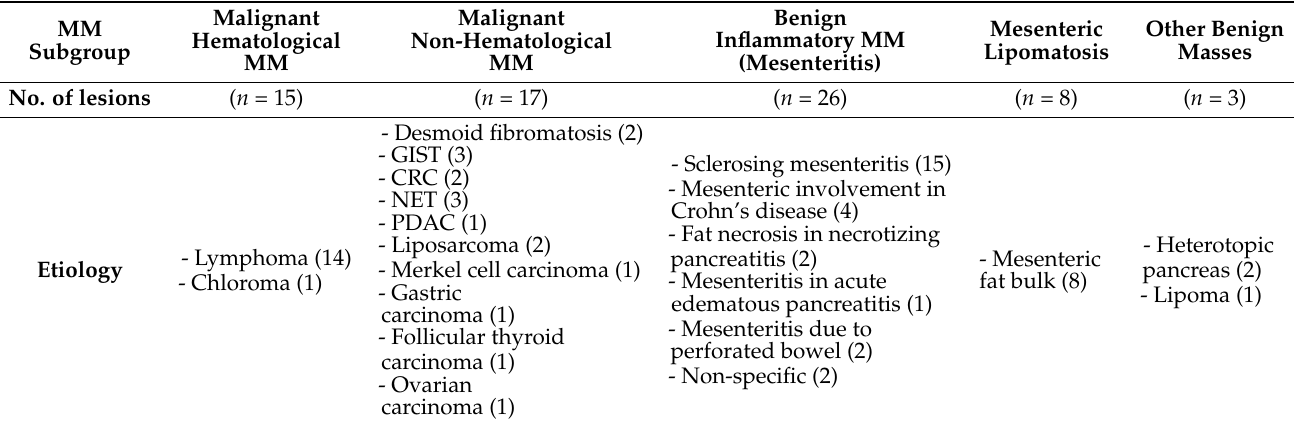
Table 1. Overview of all diagnostic entities in the study sample ( n =